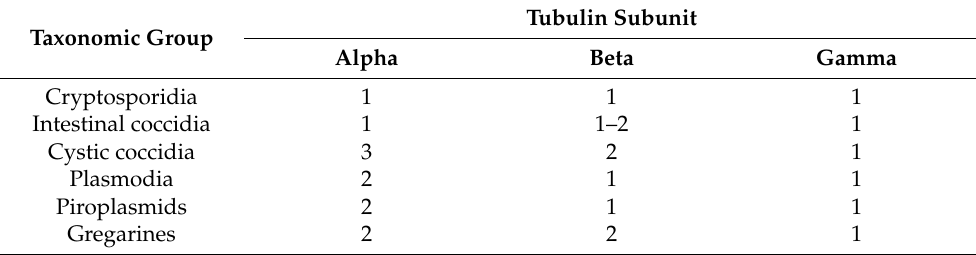
Table 2. Number of tubulin subunit isoforms for the major taxonomic groups in the alveolates. Taxonomic